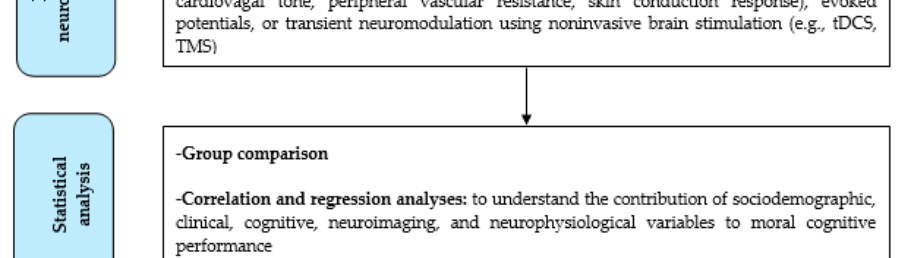
Figure A1. A proposed roadmap for future research addressing moral cognition in multiple sclerosis.